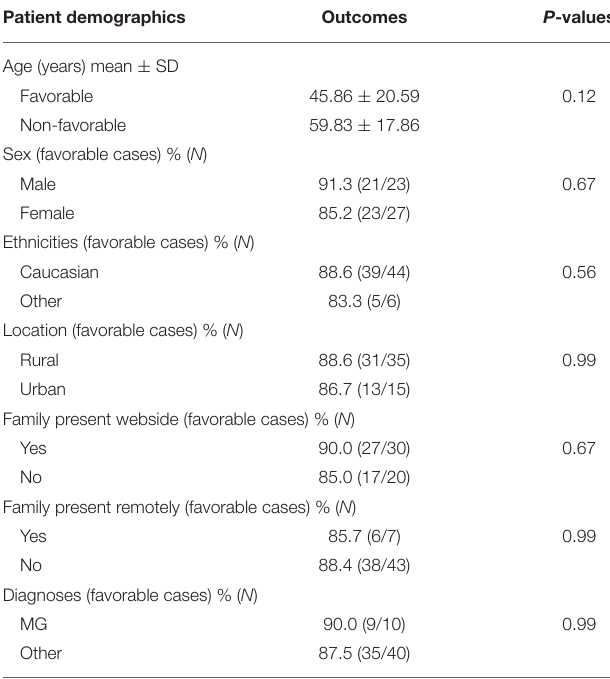
TABLE 3 | Demographic factors on survey